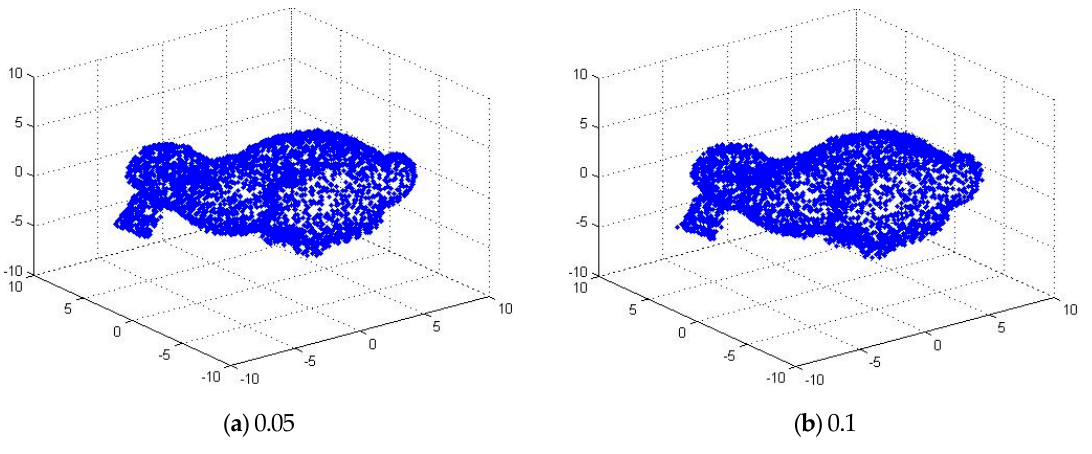
Figure 12. The point cloud data after adding the noise. Sensors 2017 , 17 , 1